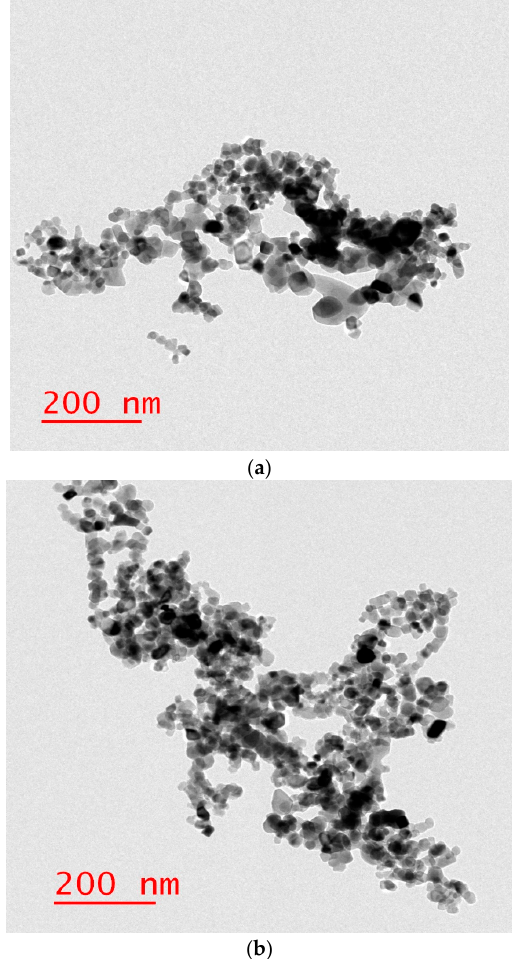
Figure 2. Transmission electron microscopy images: ( a ) TiO 2 nanoparticles, and ( b ) TiO 2 -PDA nanoparticles.